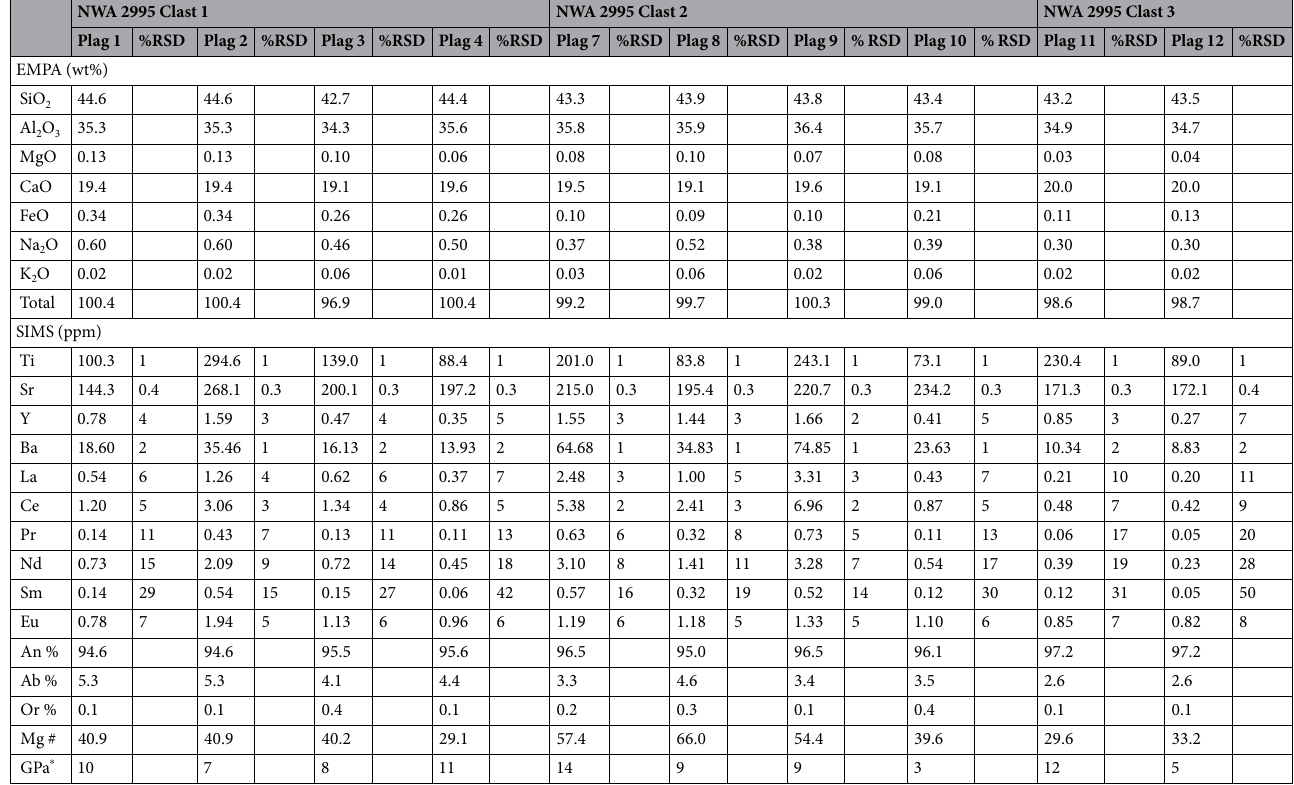
Table 1. NWA 2995 plagioclase major-elements as measured by EMP) and trace-elements (by SIMS) For SIMS data % Relative Standard deviation (%RSD) is also shown. Reference images of these clasts are shown in Fig. S7. * See SOM for details of calculation. ± 3 GPa (1 σ ) for all